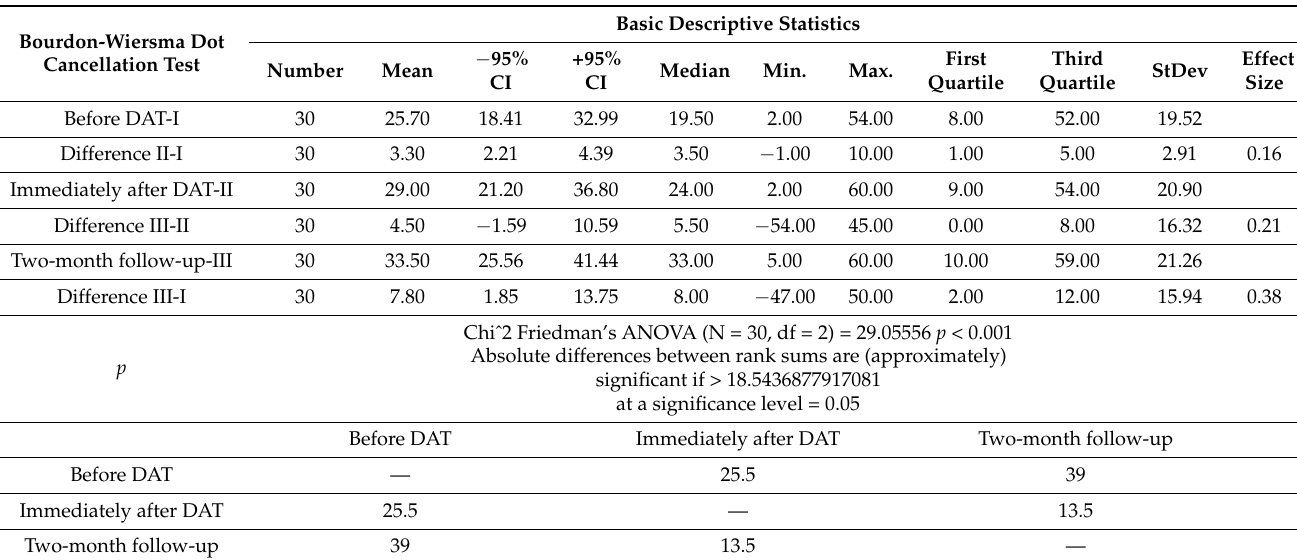
Table 5. Bourdon–Wiersma Dot Cancellation—analyses of the measurements performed over time.